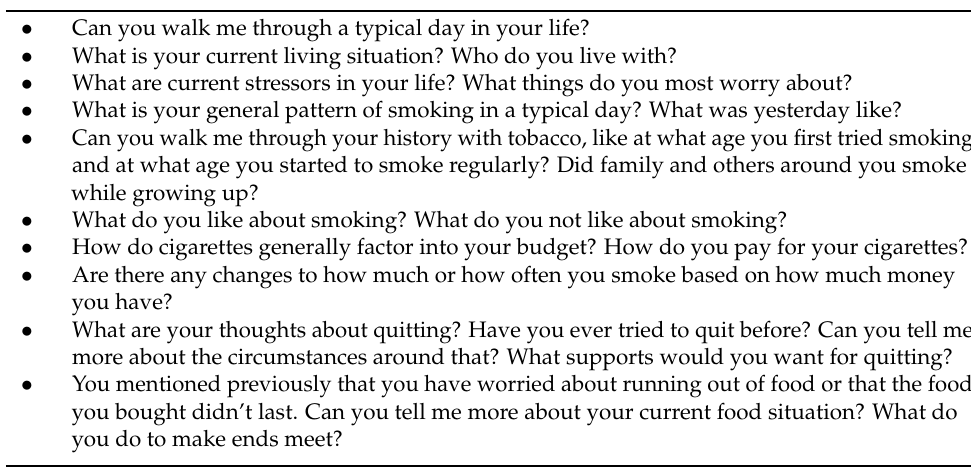
Table 1. Sample Interview Questions and Probes.